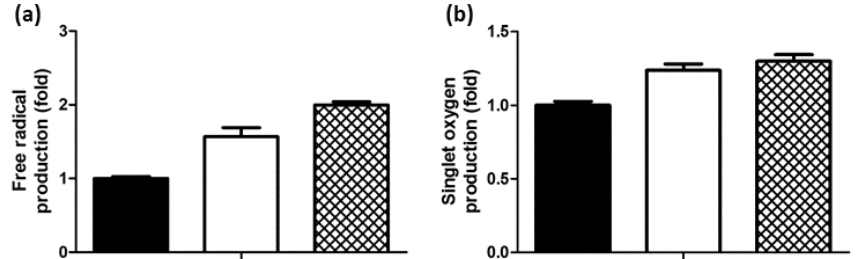
Figure 1. Generation of ( a ) free radicals and ( b ) singlet oxygen from curcumin-photodynamic therapy (PDT) detected with 1,1-diphenyl-2-picrylhydrazyl (DPPH) and 1,3-diphenylisobenzofuran (DPBF), respectively. The filled and open columns represent the untreated (control) and curcumin-PDT samples, respectively. The mesh columns represent the positive control: ascorbic acid in ( a ) and PDT with rose bengal in ( b ).